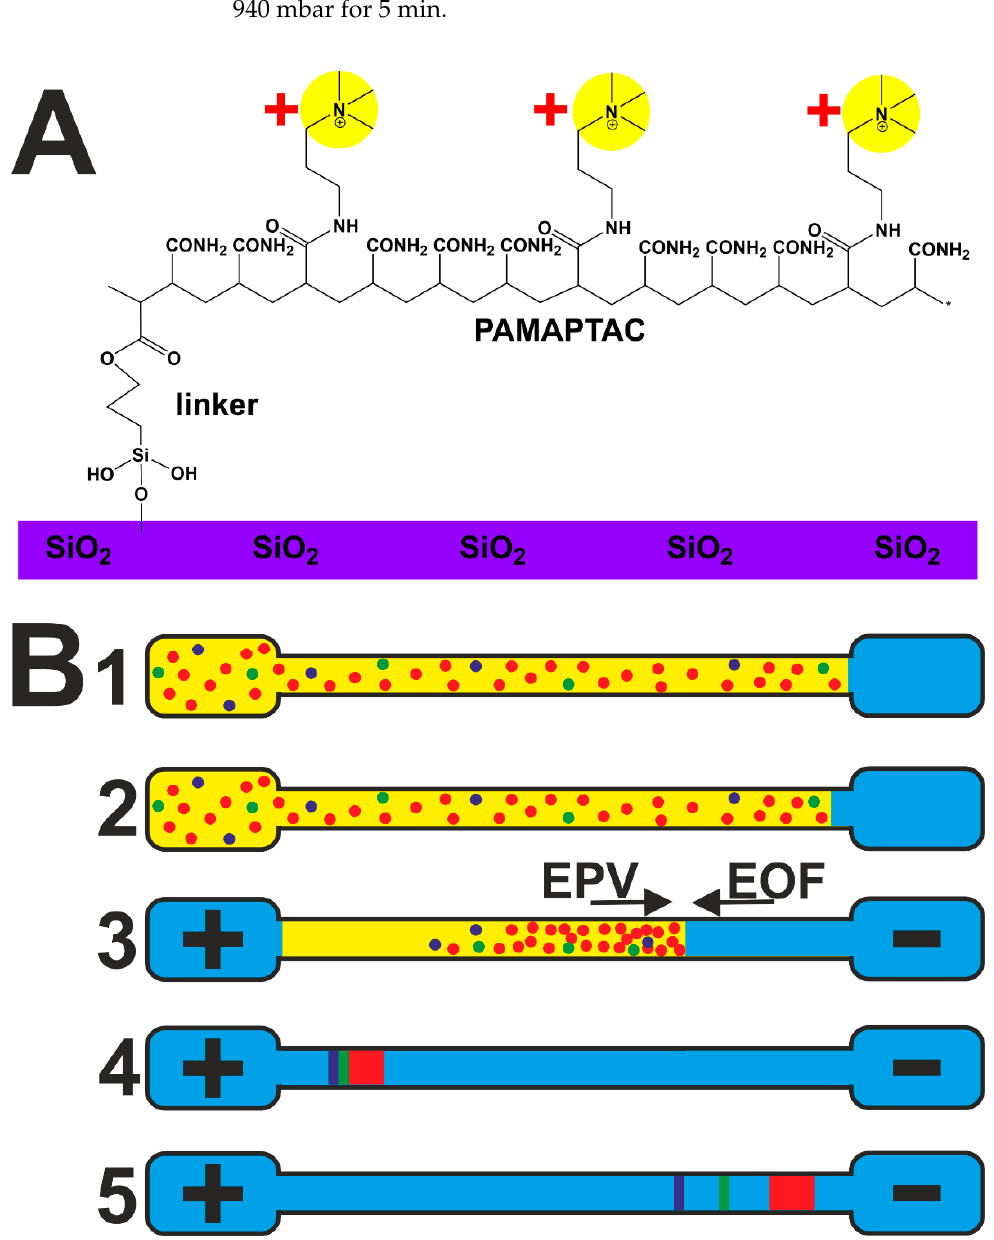
Figure 5. The copolymer PAMAPTAC covalently bonded through a linker (3-(hydroxysilyl)propyl methacrylate) to the inner surface of a fused silica capillary ( A ); ( B ) working procedure or electrophoretic stacking combined with the whole capillary sample injection: 1—filling the whole capillary through the application of a pressure of 940 mbar; 2—drawing short zones of BGE into the exit end of the capillary by an under pressure of − 50 mbar; 3—turning on the separation voltage of +30 kV causes electrophoretic migration of the analyte (EPV—electrophoretic velocity) and drawing of the BGE from the detection end at the speed of the EOF; 4—stacking the analyte on the background of the zone of sodium ions by the transient pseudo-isotachophoresis technique; 5—separation of the concentration zones by the CZE technique. BGE—light blue; sample matrix—yellow; sodium—red; ADMA—green; SDMA—dark